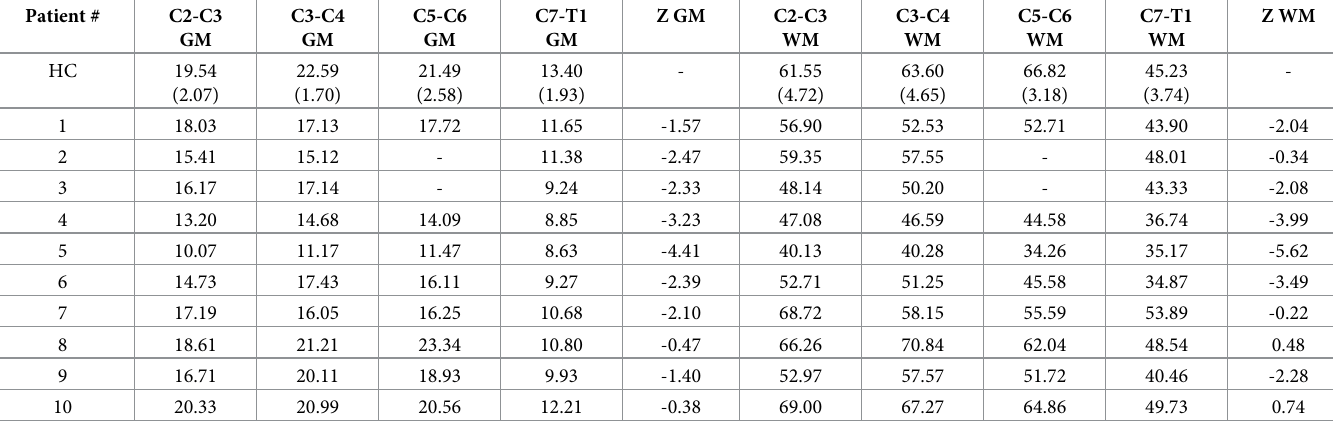
GM area and WM area for the 10 MND patients in square mm. The first line (HC) is the mean value/standard deviation for the 10 HC. For patients 1–10 the individual values at each level are listed. The total Z score (average Z score across the levels) for GM and WM are also